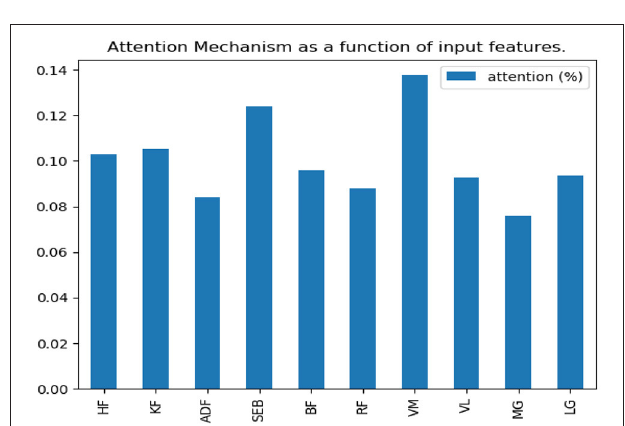
FIGURE 7 | Attention probability distribution of input features on running data set.